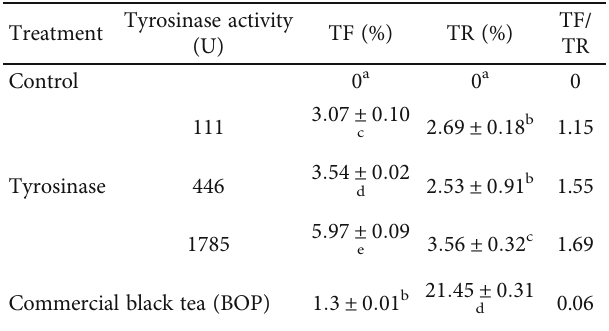
Figure 1: HPLC chromatogram of individual catechin and gallic acid of tyrosinase and β -glucosidase-treated tea leaves. Table 2: Thea fl avin and thearubigin content of tea leaf extract treated with